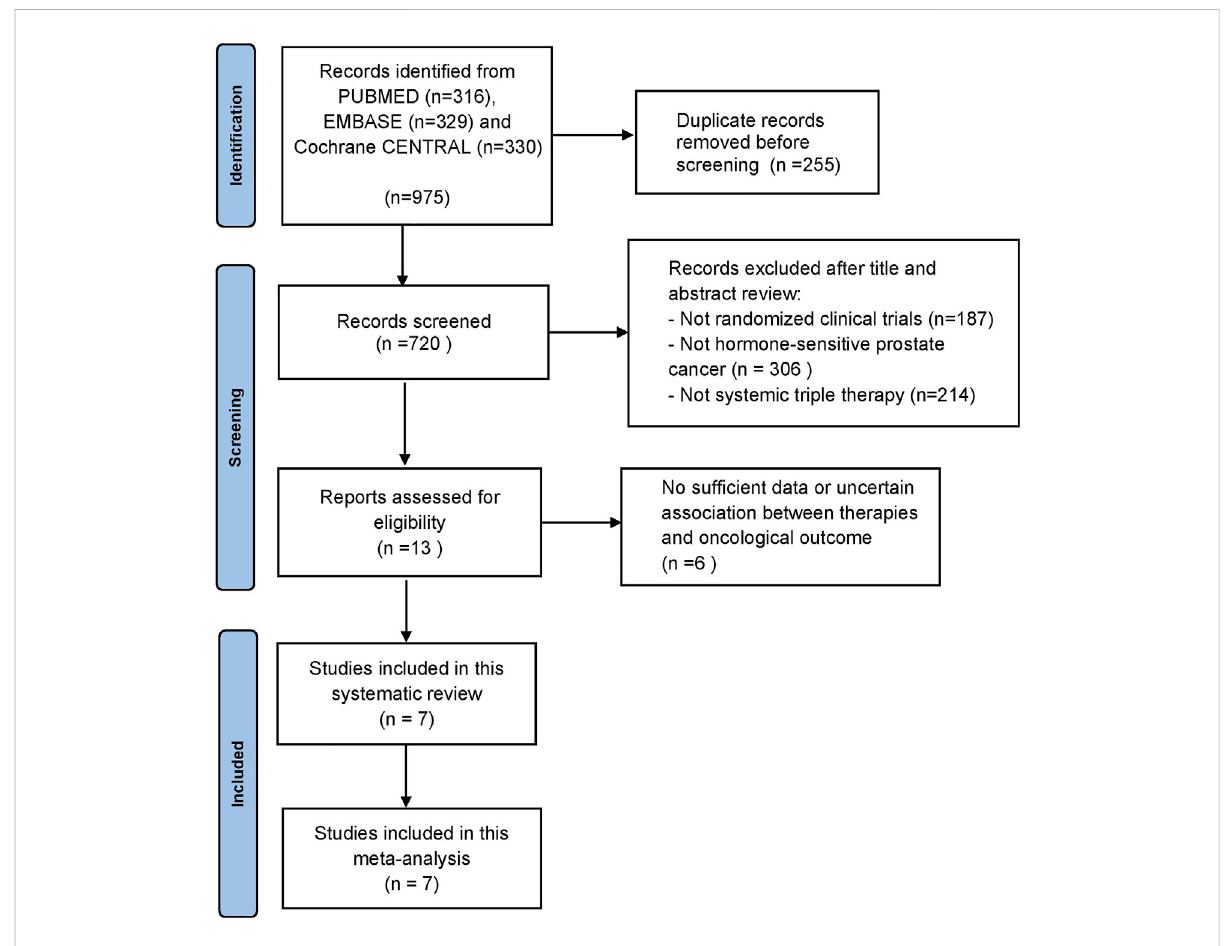
The PRISMA fl ow chart detailing the study selection